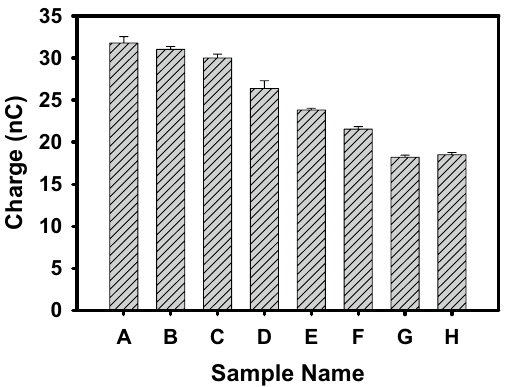
Figure 8. Charge of various PP-MB-NW of sample A–H (calculated using Standard EN 1149-1).